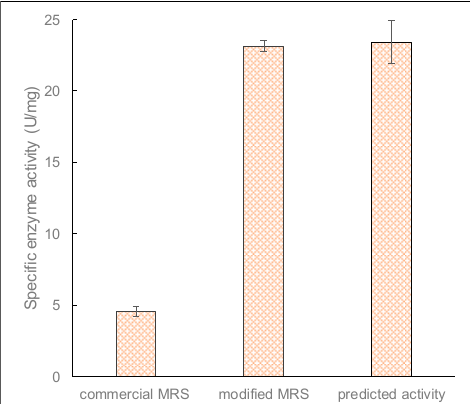
Figure 9. The specific enzyme activity of β -galactosidase before and optimization, and activity predicted by the response surface methodology (RSM). Cultures were grown in 20 mL of modified MRS broth placed in 30 mL capacity universal media glass bottles. Results are shown as the mean ± standard deviation of three independent experiments.